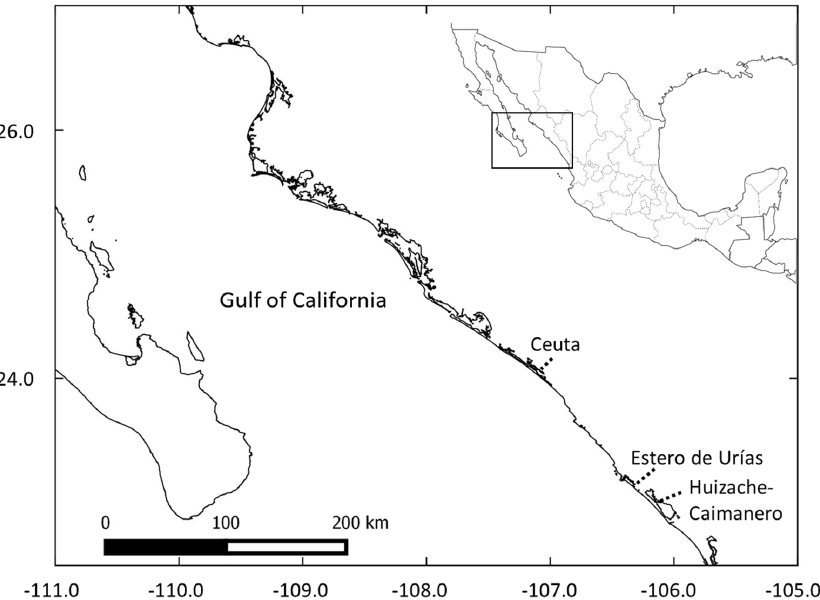
Figure 1. Map showing the sampling locations of the three lagoon systems in Sinaloa, Mexico. Zoomed panels for each lagoon are shown in Figure